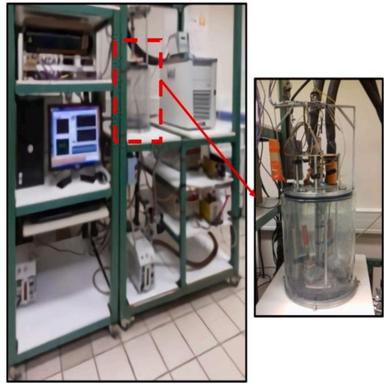
Thermal conductivity and diffusivity measurement system.